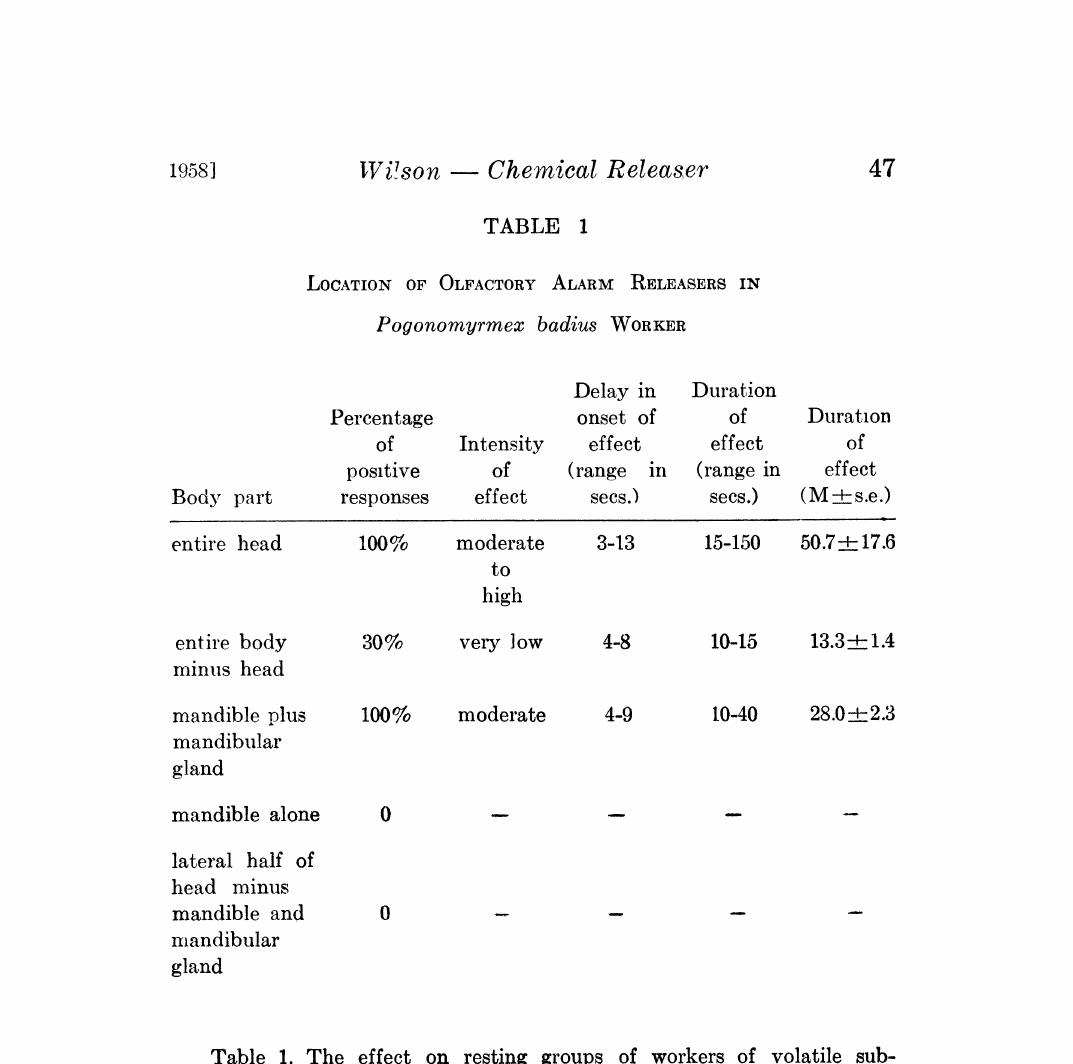
Table 1. The effect on resting groups of workers of volatile sub- stances artificially released from various body parts by crushing. :Each selected part was separately crushed between two pieces of glass and then quickly exposed at a point four to five centimeters above groups of resting workers collected just outside the nest entrance. The results given ir this table come from ten replications of the experiment. The lag in onset of behavior was measured to the nearest second, the duration of effect to the nearest five seconds. In the case of a negative response, the crushed material was held in position one minute before being withdrawn. In the course of dissection it was found expedient to leave the mandibular gland attached to the mandible in order to preserve the contents of the reservvr intact. Further explanation in